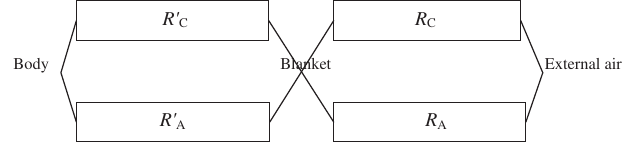
FIG. 6. Representation of the system between body and external air: R 0 and R represent resistances to energy transfer C C by conduction or convection; R 0 and R represent resistances to A A radiant energy transfer. These resistances are the inverses of the coefficients in